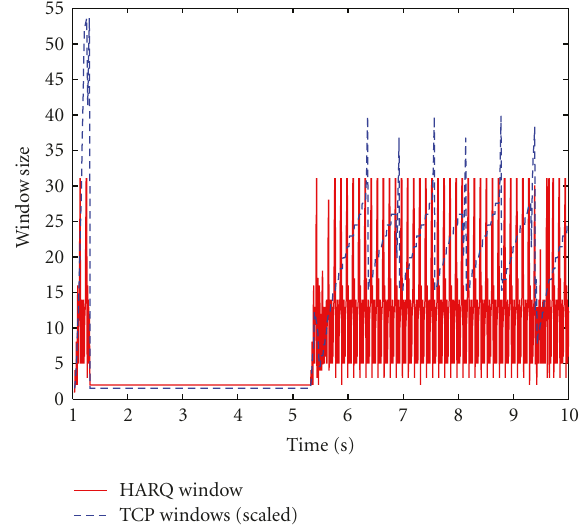
Figure 9: Joint evolution of the HARQ sender window and TCP congestion window during ad hoc transmission.